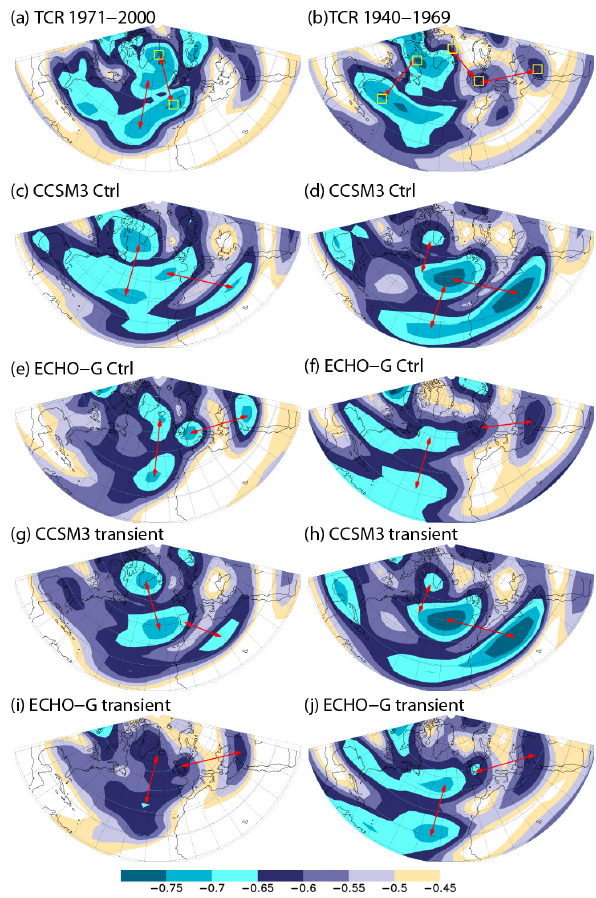
Fig. 5. Composites of teleconnectivity for all periods with high (left panels) and low (right panels) spatial correlation in the Atlantic: (a) TCR for period 1971–2000, (b) TCR for period 1940–1969, (c, d) composites of all CCSM3 Ctrl simulations, (e, f) composites of the ECHO-G Ctrl1990 simulation, (g, h) composites of all CCSM3 transient simulations and (i, j) composites of all ECHO-G transient simulations. Note that the composites are selected according to a distance of at least two standard deviations from the mean of the corresponding spatial correlation times series of Fig. 3. The yellow squares in (a) and (b) show the location for the index definition in Sect.